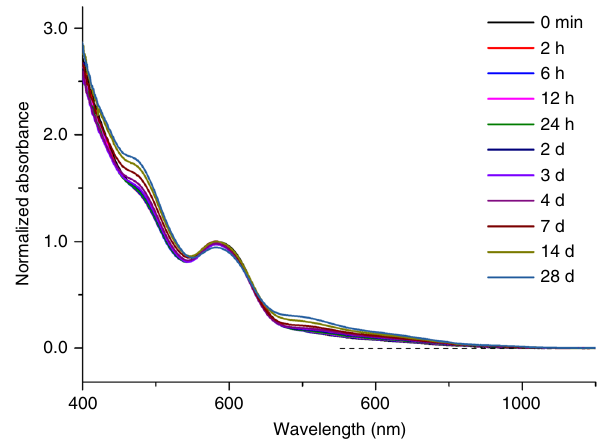
Fig. 6 Enhanced stability of [Au 23 (SR) 16 @ x CTA] − . Time-course ultraviolet- visible absorption spectra of [Au 23 (SR) 16 @ x CTA] − dissolved in ethanol, where SR and CTA denote thiolate and cetyltrimethylammonium ligands, respectively. All absorption spectra are normalized to optical density at 589 nm at t =